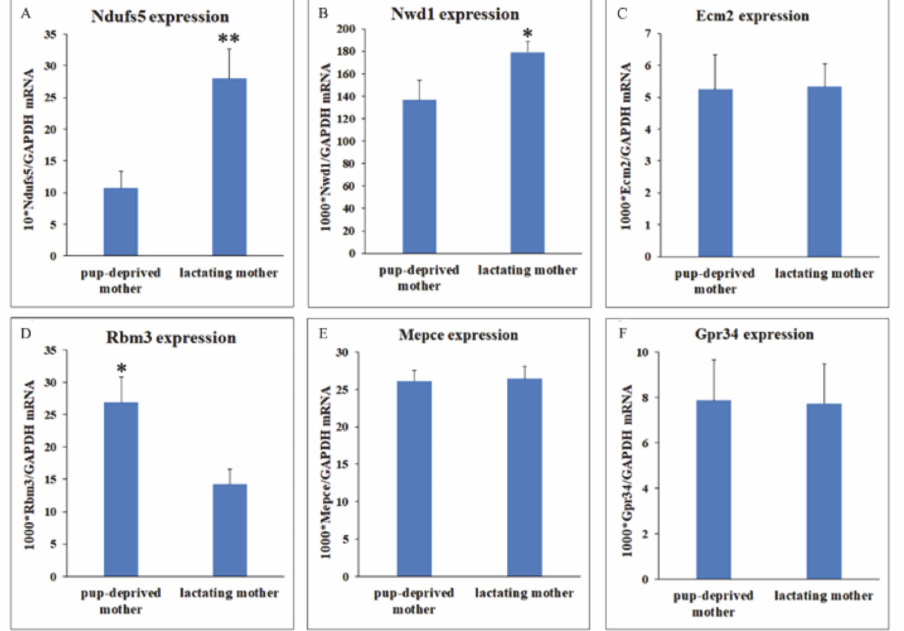
Figure 4. RT-PCR validation of DEGs in the MPOA of pup-deprived and lactating mothers (n = 11 for both groups). ( A – C ): mRNA levels of genes with higher expression in lactating moth- ers according to the RNA-Seq. Data, shown as ratio of GAPDH mRNA levels (mean ± SEM). Ndufs5 and Nwd1 mRNA levels were significantly higher in lactating mothers (** = p < 0.01, * = p < 0.05). Expression of Ecm2 did not differ significantly. ( D – F ): mRNA levels of genes with higher expression in pup-deprived mothers according to the RNA-Seq. Data, shown as ratio of GAPDH mRNA levels (mean ± SEM). Rbm3 mRNA level was significantly higher in pup-deprived mothers (* = p < 0.05). Mepce and Gpr34 expression did not differ